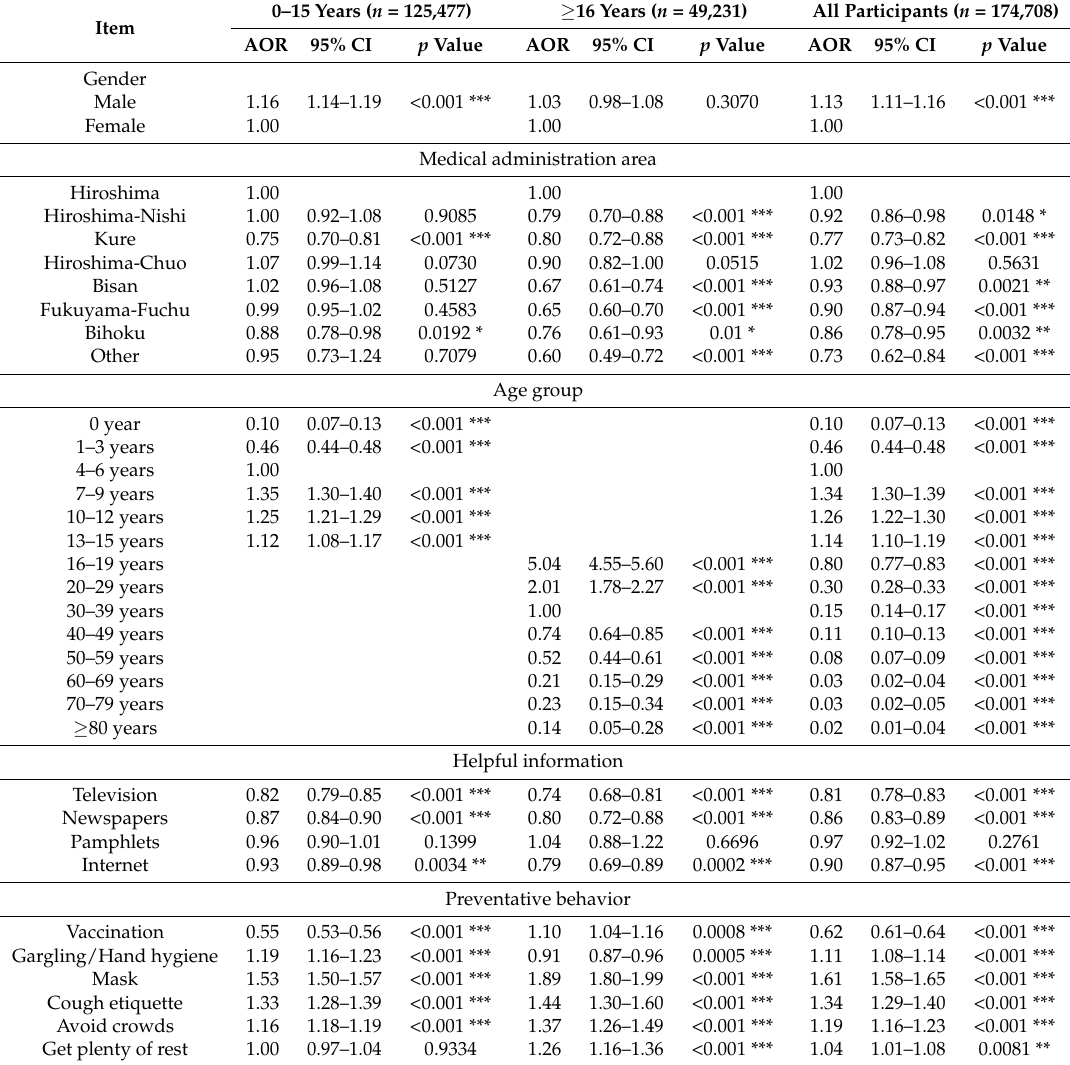
Table 5. Factors associated with influenza infection †